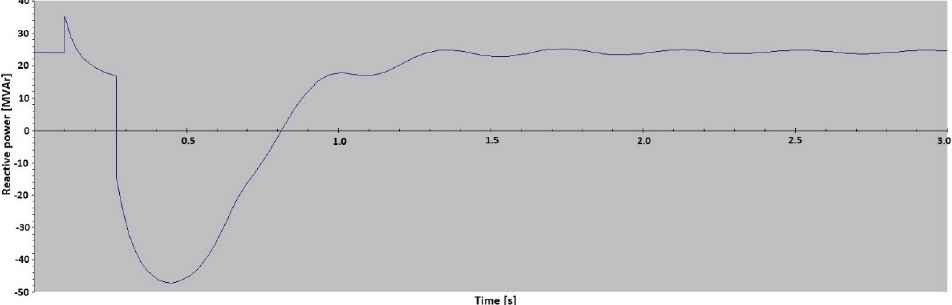
Figure 20. Simulation results of reactive power of Generator 2 during the three-phase fault with the fault duration of 170 ms.